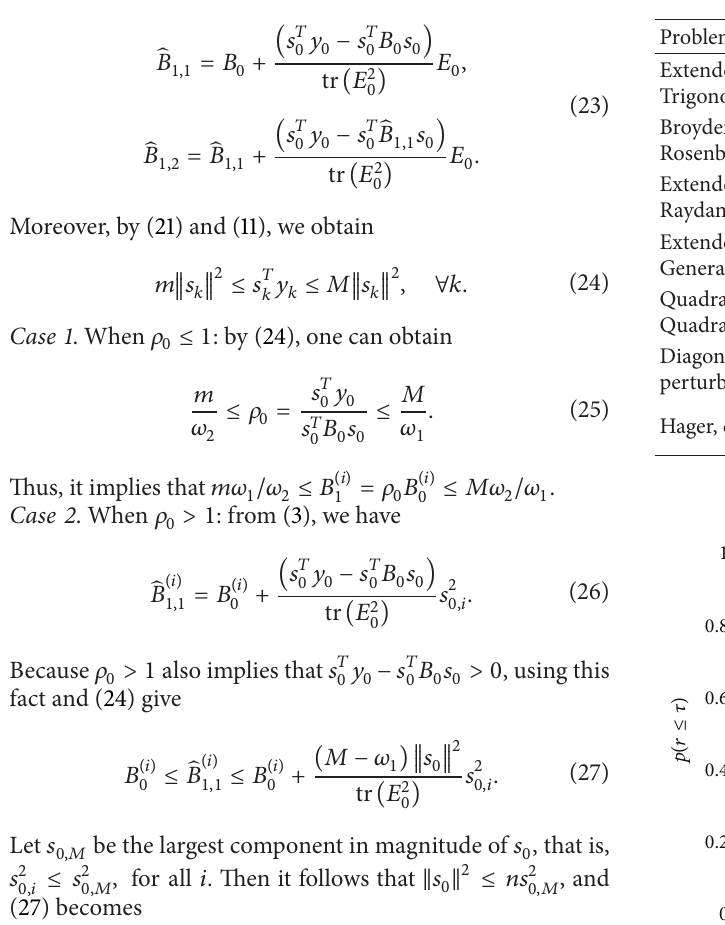
Table 1: Test problem and its dimension.